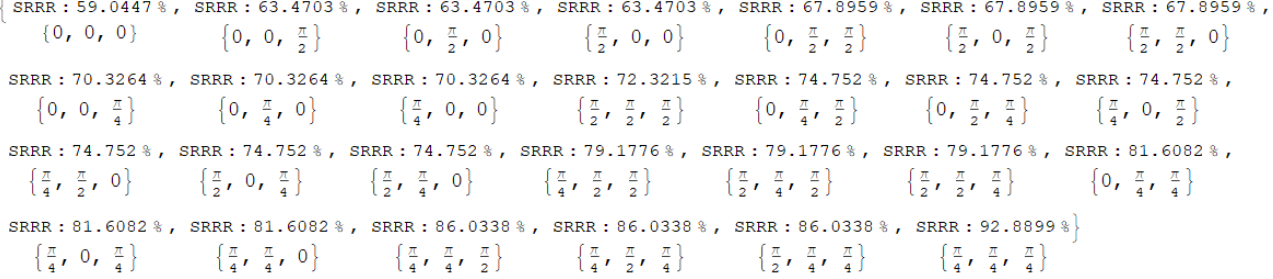
Figure 9. Solar Radiation Reception Rate for m = 3 and n = 2 at the equinox in the region of Makkah, Saudi Arabia.